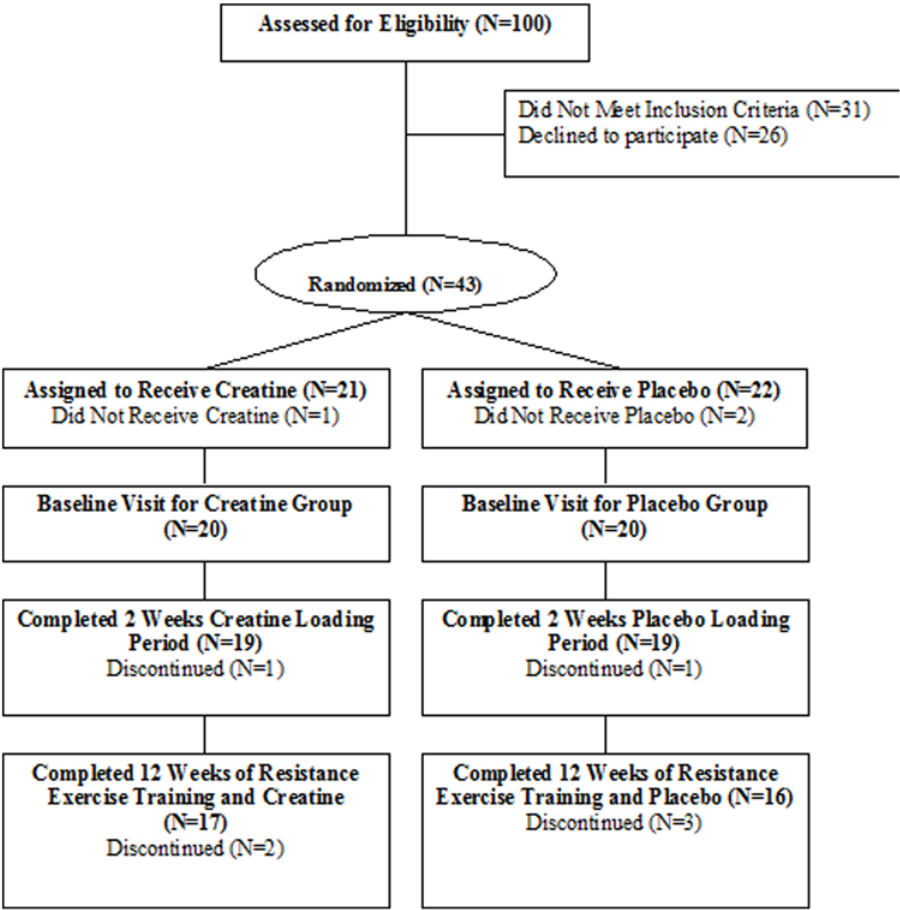
Figure 1. CONSORT Diagram showing the disposition of subjects randomized to receive creatine monohydrate or an equivalent number of placebo capsules for 14 weeks.